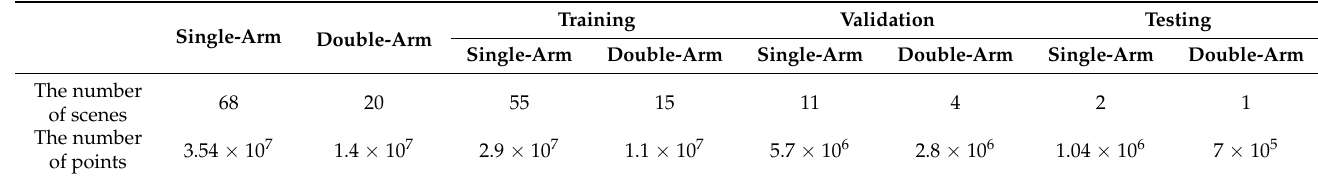
Table 2. Distribution of the number of rooms for the S3DIS dataset.